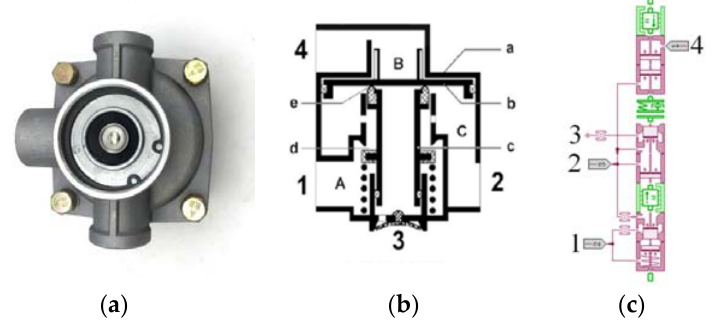
Figure 3. Relay valve. ( a ) Appearance. ( b ) Schematic diagram. ( c ) Submodel in AMESim. In the